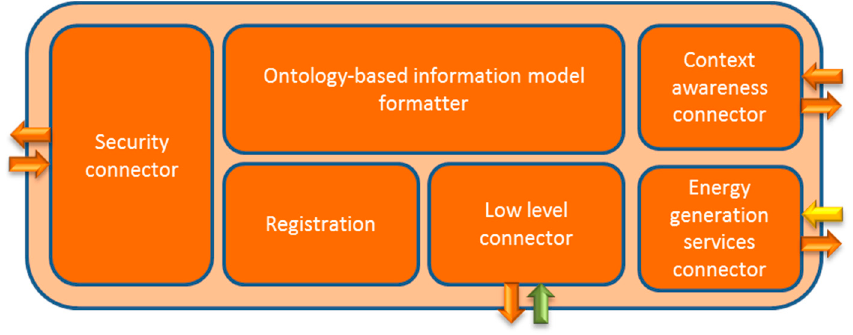
Figure 8. Data processing done in the Semantic Capabilities module.